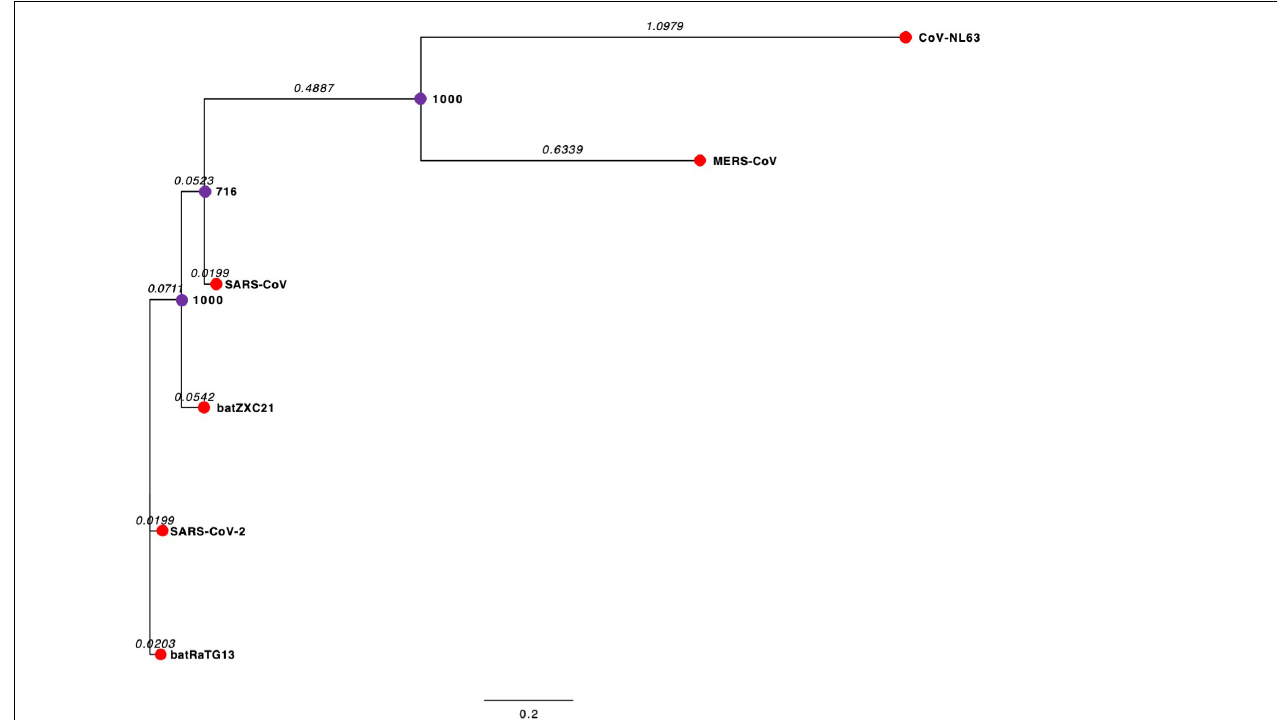
FIGURE 2 | Phylogenetic Tree of CoVs. The external node in the red circle represents each CoV. The internal node in the purple circles represents hypothetical ancestors for the CoVs. Horizontal branch lines represent evolutionary changes over time. The branch length (branch time) value, shown in italics, measures in time or genetic divergence unit. The longer the horizontal line, the larger the number of genetic changes. The bottom of the figure has a bar that provides the scale for the branch lengths. The bootstrap value is presented in bold. The bootstrap value provides confidence for each clade of the observed tree. The higher the bootstrap value, the greater the confidence level of the clade in the phylogenetic